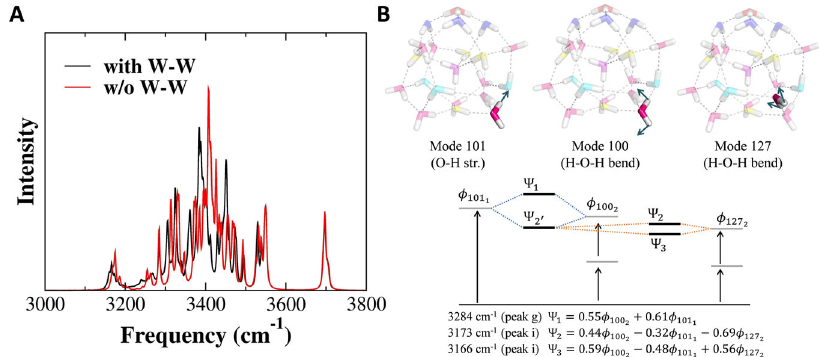
Fig. 4 On the effect of water – water (W – W) interactions. A Comparison of the IR spectra obtained by VQDPT2 with and without the harmonic coupling between water molecules in the PES. Note that the H 3 O + (H 2 O) 3 moiety has all inter-molecular couplings included in both cases. B The vibrational modes, the resonance diagram, and the component of vibrational wavefunctions for the intra- and inter-molecular Fermi resonance of the AAD-type water molecules.